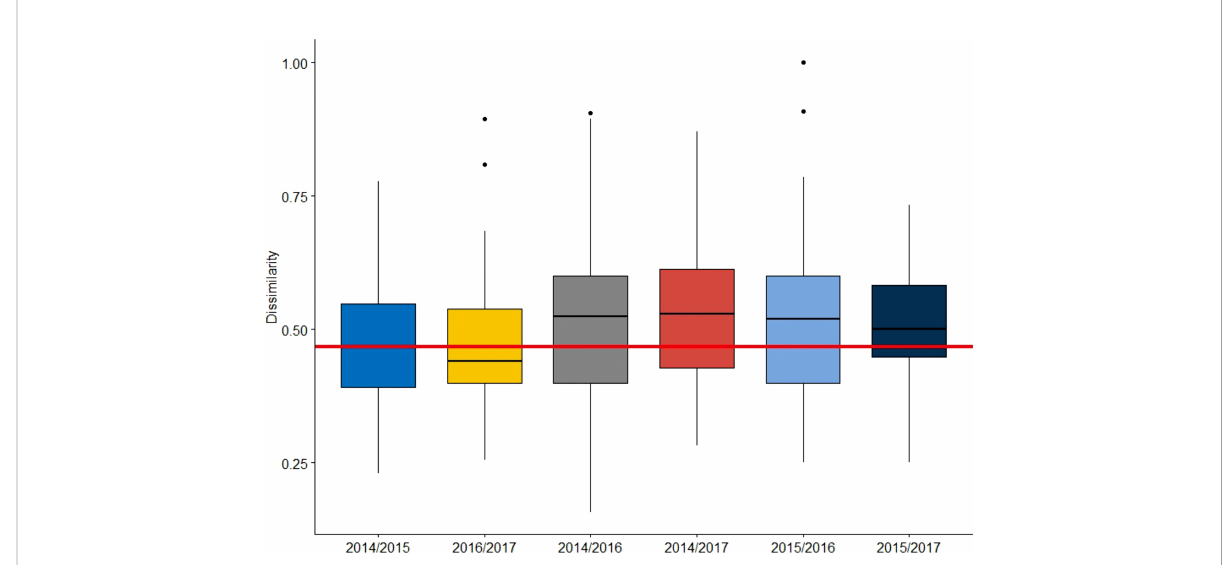
FIGURE 10 Pairwise temporal beta-diversity values for speci fi c years before (2014 – 2015) and during (2016 – 2017) the MHW events across 45 sites in the northern East China Sea. The horizontal line indicates the smallest dissimilarity observed between 2016 and